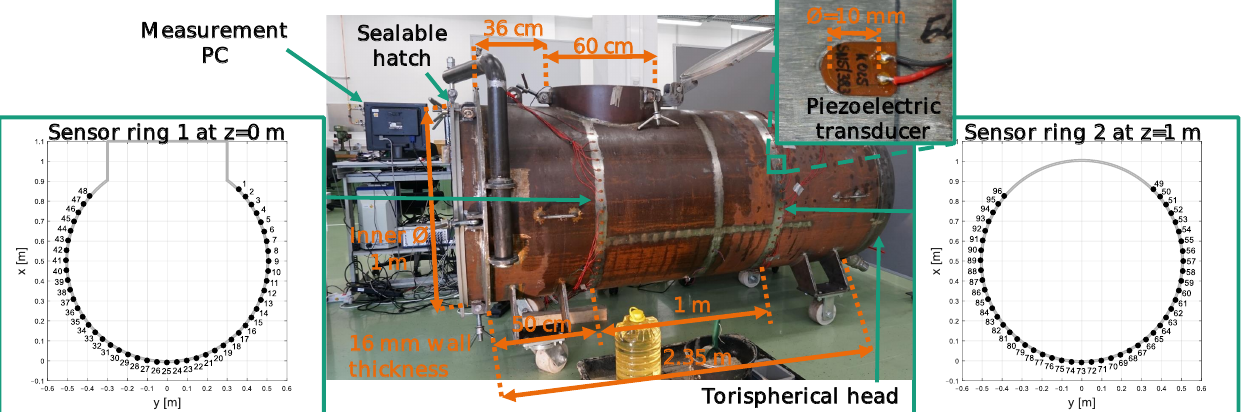
Figure 2. Experimental mock-up used to assemble guided elastic wave data of various filling states. The left - and right -side display schematic cross sections of the vessel with the exact sensor placement (black dots) for the two sensor rings with the global sensor numbering from 1 to